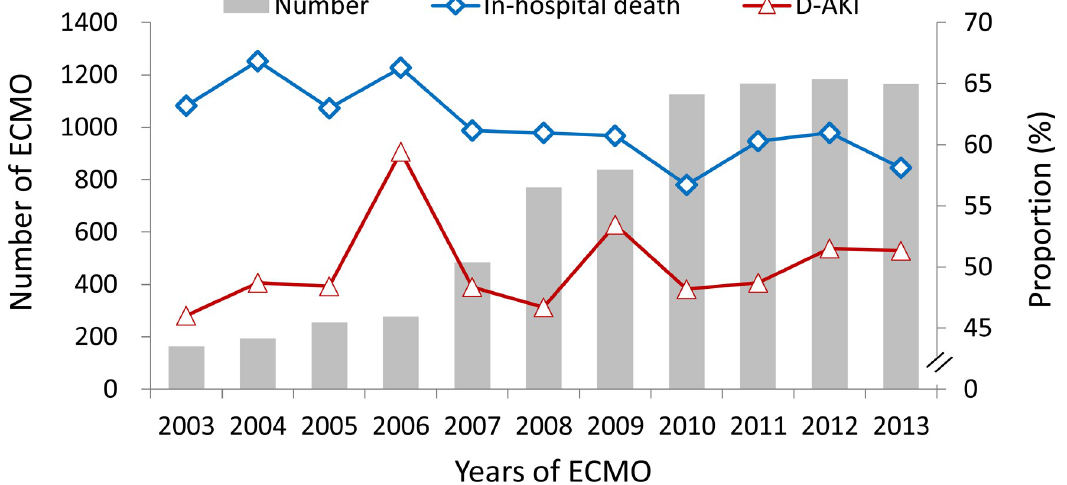
Fig 2. The number of ECMO, proportion of D-AKI (P trend = 0.415) and proportion of in-hospital mortality (P trend = 0.007) between 2003 and